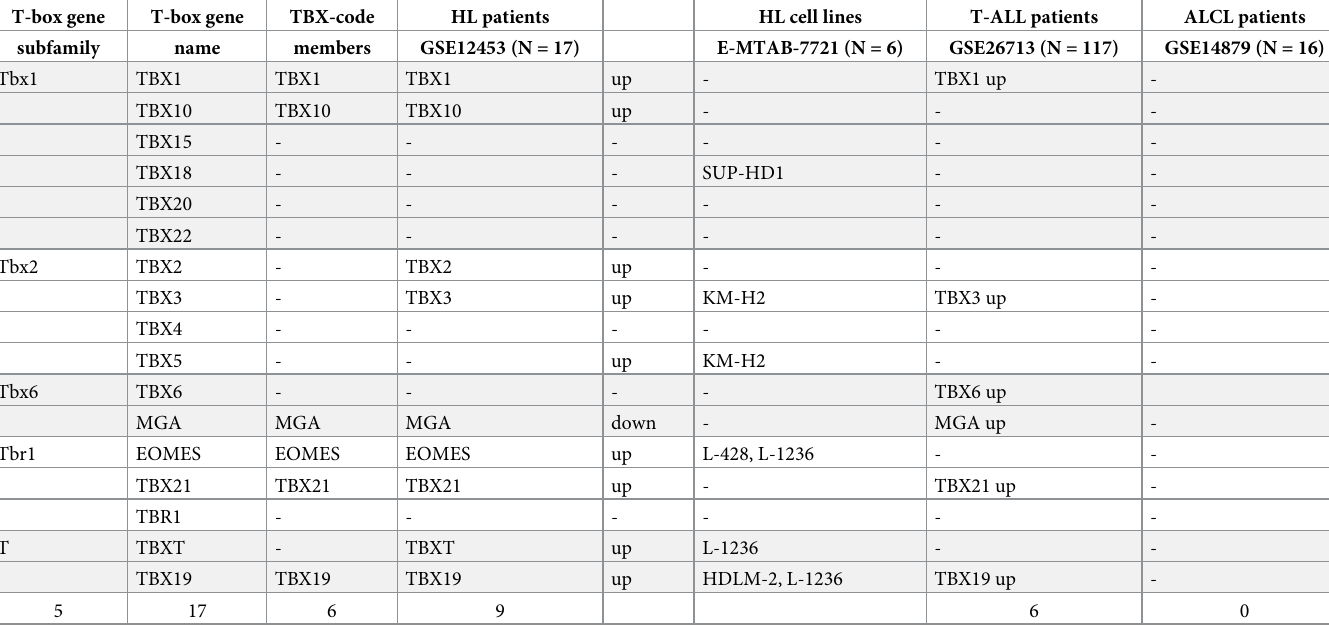
Table 1. T-box gene activity in HL, T-ALL and ALCL. T-box gene T-box